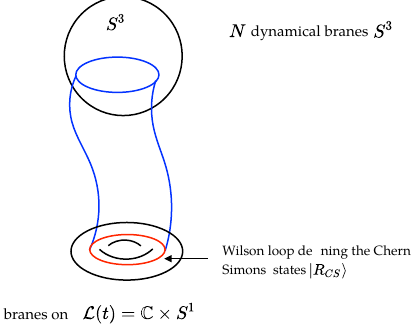
Figure 15 . Displacing the probe branes away from S 3 gives rise to open string instantons of finite area, stretched between the branes.